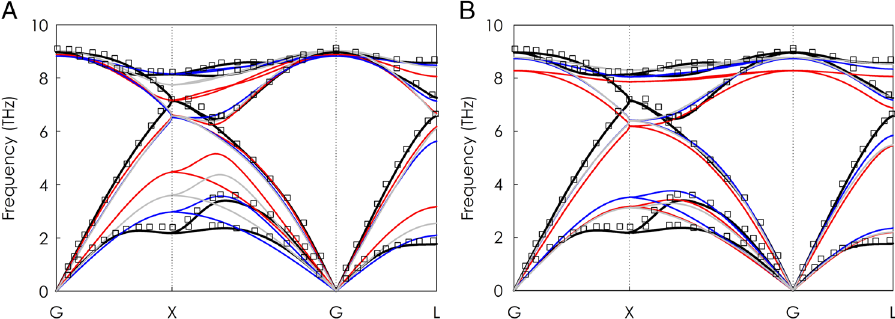
Fig. 5 DFT, and experimental 62 phonon dispersion for Ge, along with different POPs. a DFT ( black ), M3BC-1 ( red ), M3BC-2 ( blue ), M3BC-3 ( gray ) and experiments ( squares ) are shown. These EIPs are shown to demonstrate the importance of 2nd order force constants in reproducing correct phonon dispersion. From best to worst agreement in 2nd order force constant error, M3BC-2 (5.1 × 10 − 4 Ry/Bohr 2 mean absolute error in 2nd order IFCs), M3BC-3 (9.7 × 10 − 4 Ry/Bohr 2 mean absolute error in 2nd order IFCs), and M3BC-1 (7.4 × 10 − 3 Ry/Bohr 2 mean absolute error in 2nd order IFCs) exhibit expected qualitative trends in phonon frequency error, especially at the zone boundaries where fl attening is unable to occur. b DFT ( black ), TBC-1 ( red ), TBC-2 ( blue ), TBC-3 ( gray ) and experiments ( squares ) are